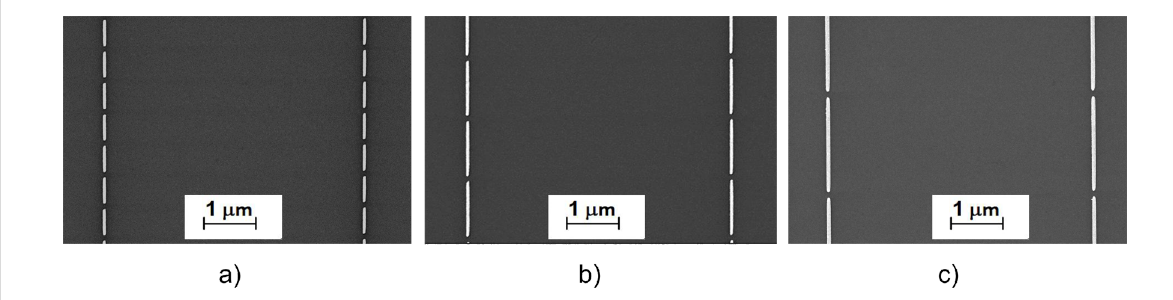
Figure 1: Typical SEM images of the fabricated Au nanoantennas for the mid-IR spectral region. Nanoantenna lengths: a) 500 nm, b) 1100 nm, c) 1900 nm.